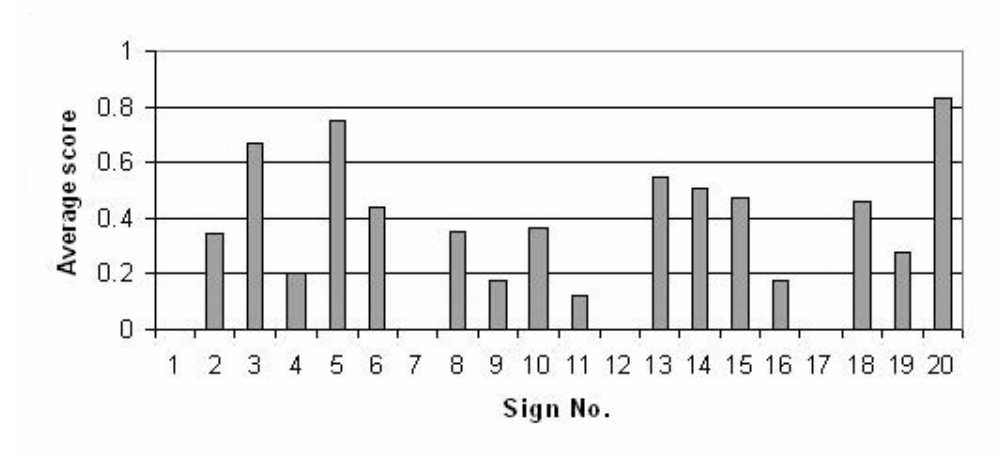
Figure 5b. Problems with Sign